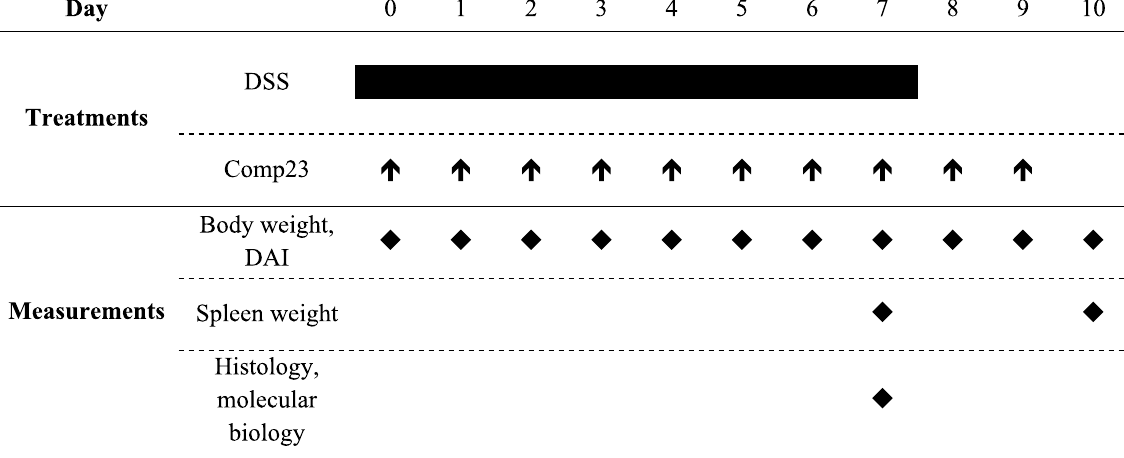
Table 2. Experimental setup investigating the effect of Comp23 in DSS-induced colitis of WT mice. During the experiment, WT mice received water for 10 days (Control and Comp23 groups) or 2.5% DSS in their drinking water for 7 days, then clear water for 3 days (DSS and DSS + Comp23 groups). Mice were treated with daily by intraperitoneal injection of Comp23 (Comp23 and DSS + Comp23 groups) or vehicle only (Control and DSS groups). Changes in the body weight of mice and disease activity index (DAI) were monitored during the whole experiment. Experiments were termined on the 7th or 10th day. Spleen weights were measured from samples derived from 7 and 10th days. Molecular biological measurements were performed on tissue samples derived from 7th